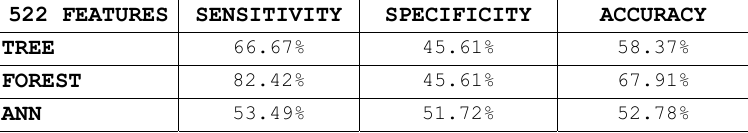
Table 6. Pixel value metrics.